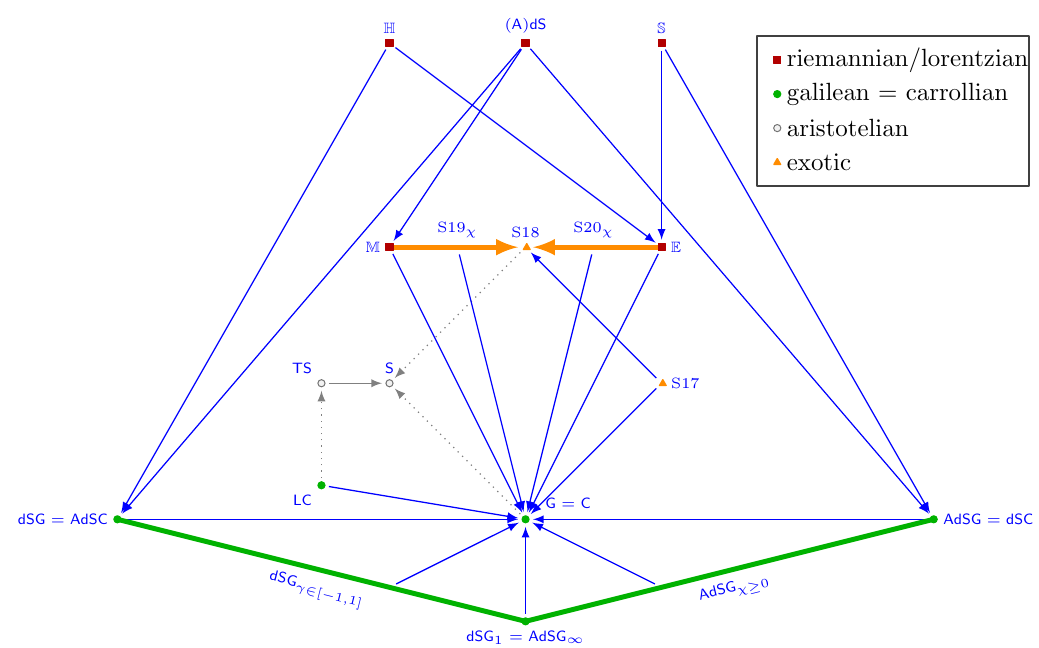
Figure 5 . Two-dimensional homogeneous spacetimes and their